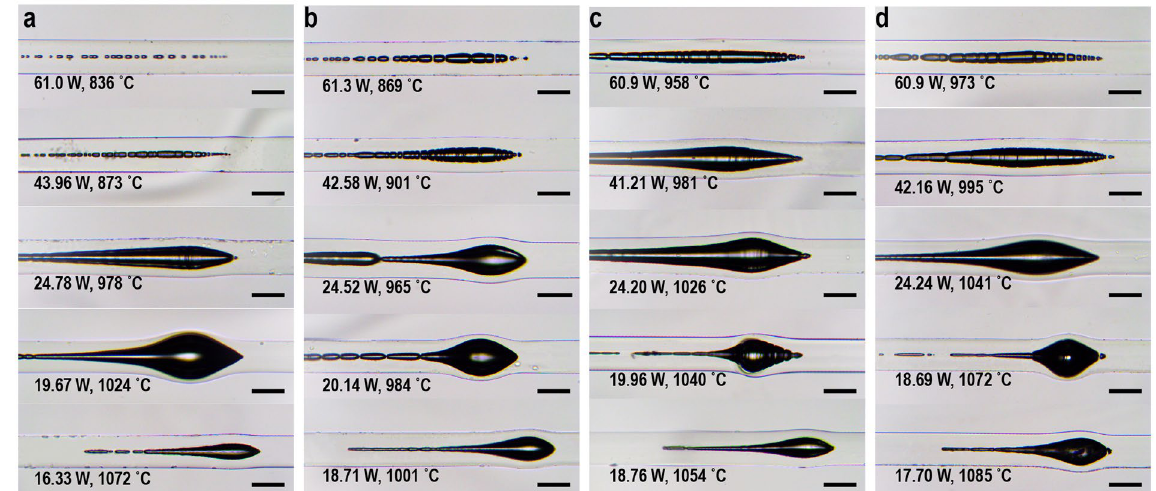
Figure 5. Micrographs of the positions of IFF in the tested fibers. ( a – d ) Are of tested fiber 1–4, respectively. Laser light was input from left to right when the IFF were triggered. In each subplot shows the input power and the temperature at which the IFF happened. The bars are of 130 μ m